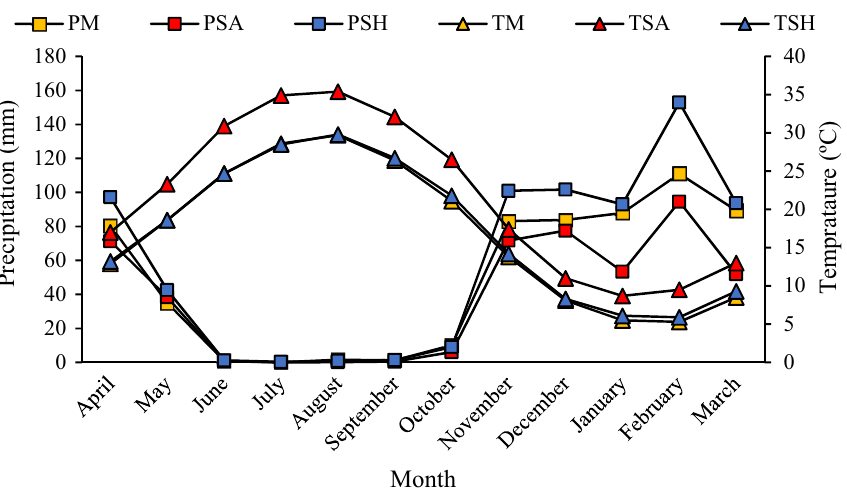
Figure 8. Climate diagrams for parts of the Zagros forests in Ilam province; PM: Precipitation Mediterranean, TM: Temperature Mediterranean, PSA: Precipitation Semi-arid, TSA: Temperature Semi-arid, PSH: Precipitation Sub-humid, TSH: Temperature Sub-humid.